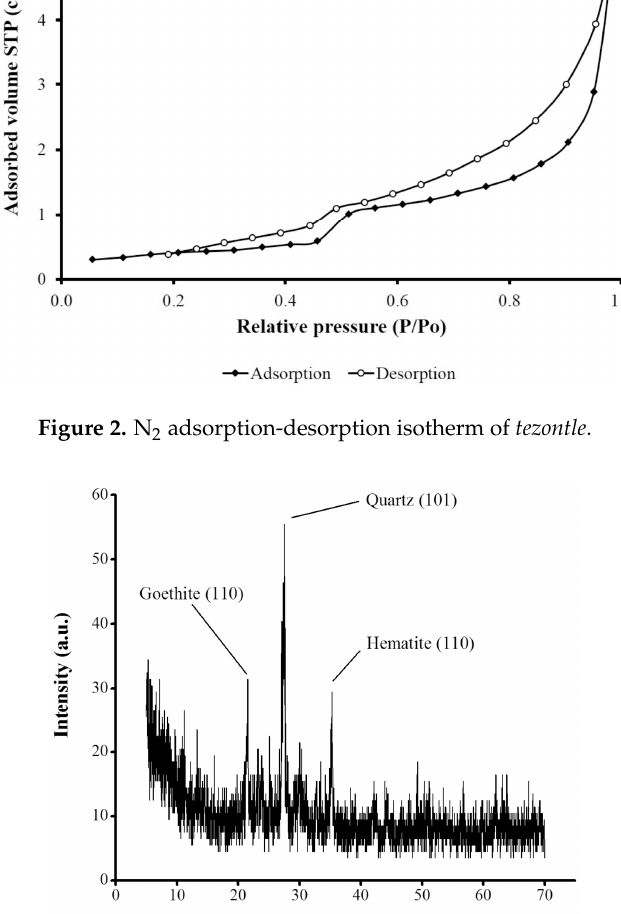
Figure 3. X-ray diffraction (XRD) pattern of tezontle .